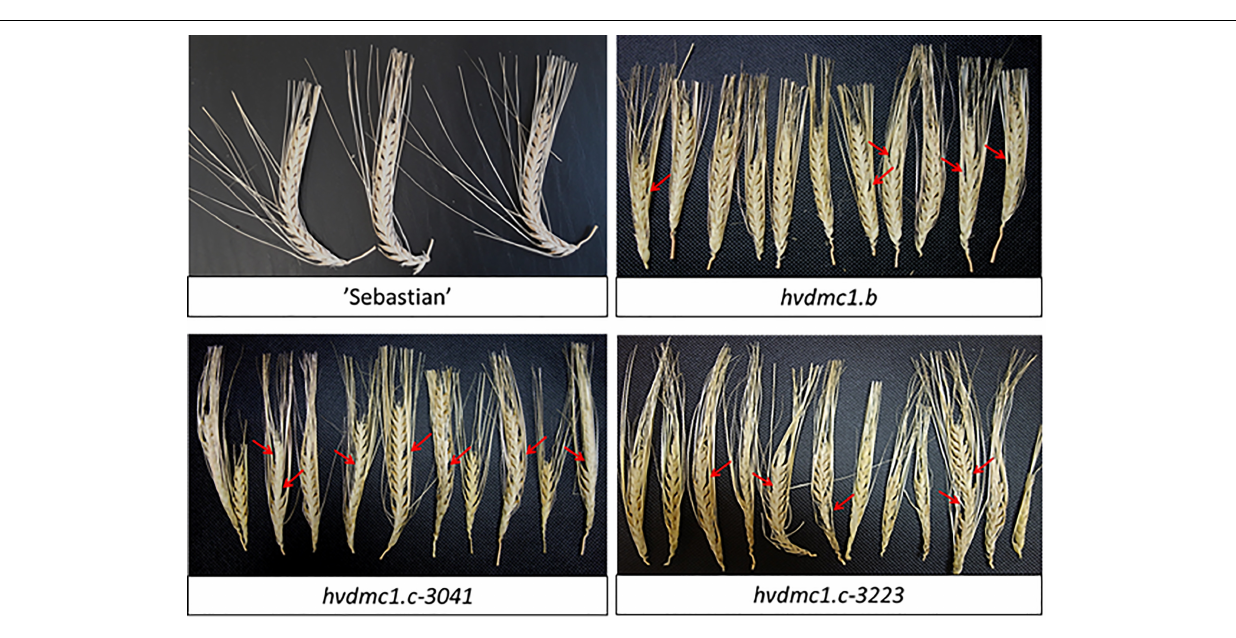
FIGURE 4 | Spikes of cv. ‘Sebastian’ and the dmc1.b, dmc1.c-3041, and dmc1.c-3223 mutants displaying partial sterility. Red arrows indicate examples of places where no grains were